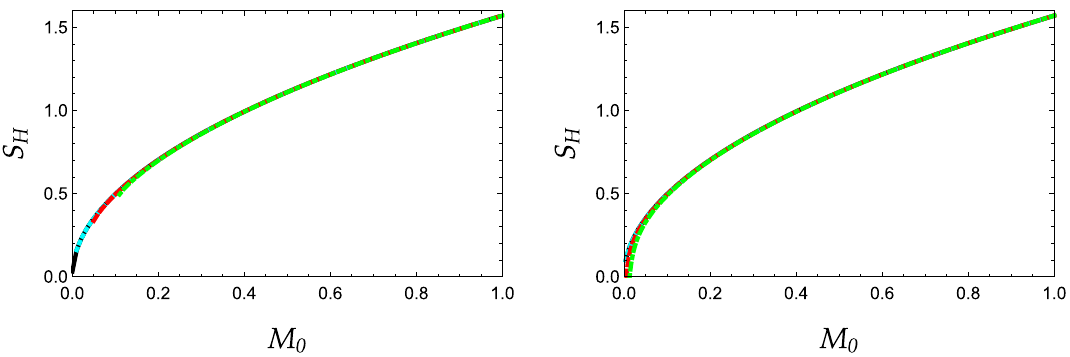
Fig. 5 BekensteinHawkingentropy S H againsttheclassicalblackhole mass M 0 for different values of the parameter ξ . Left panel: Exact black holeentropyobtainednumericallybysolvingEq.(39),versus M 0 .Right panel: Approximated black hole entropy obtained for a small value of